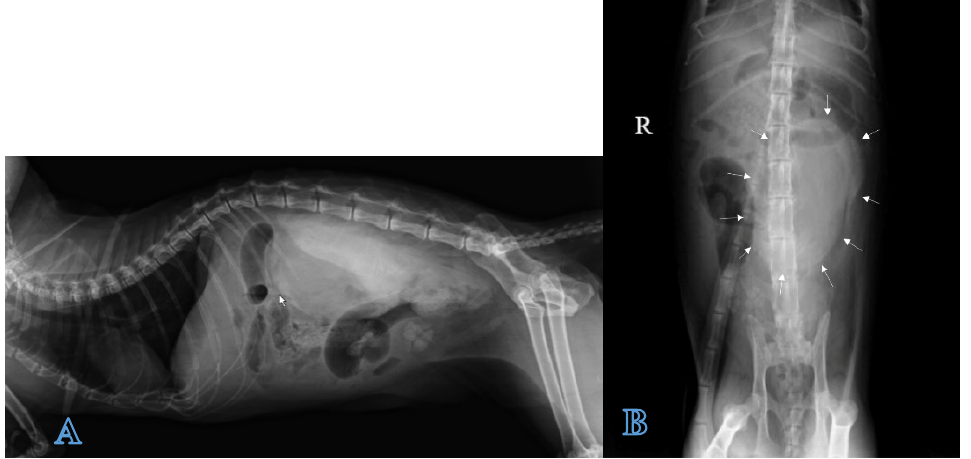
Figure 5. Positive contrast X ‐ ray exam of the abdomen: ( A ) Left lateral and ( B ) ventrodorsal projections. Contrast medium that borders the fluid collection is shown in arrows.